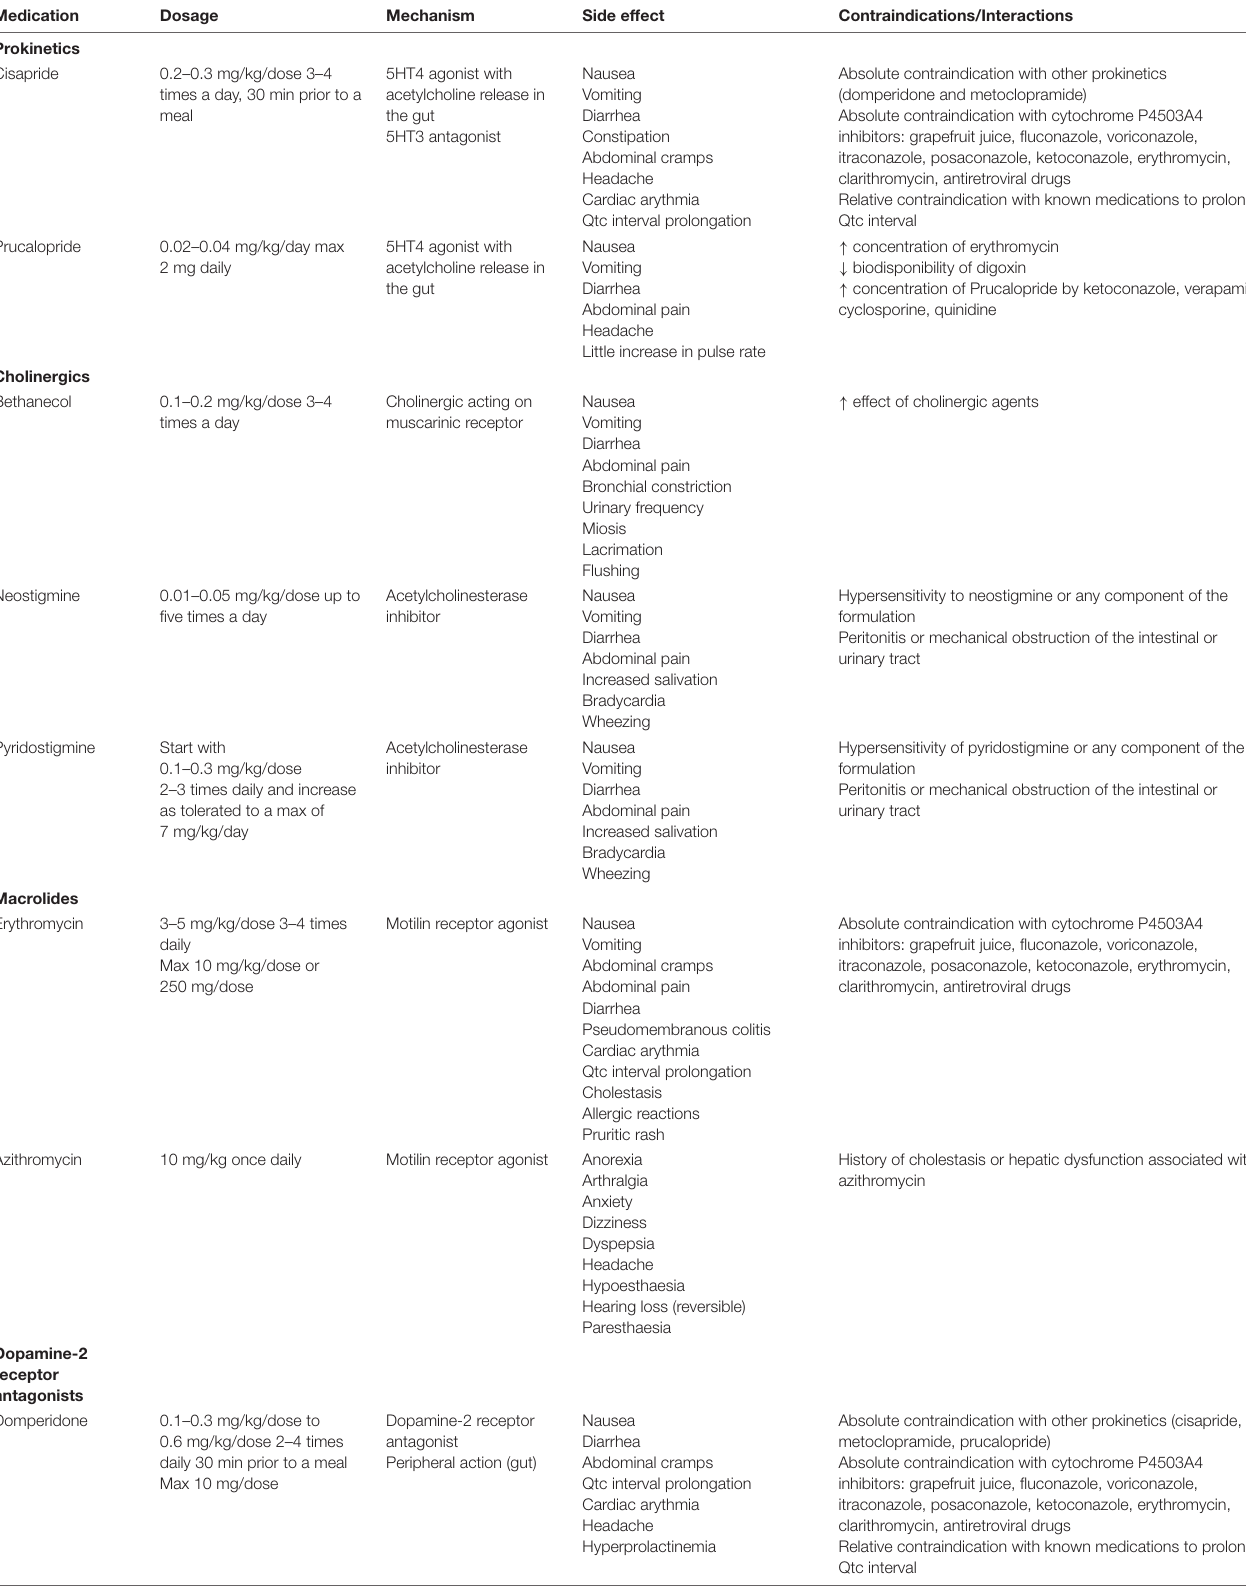
TABLE 3 | Prokinetic drugs used in Pediatric Intestinal Pseudo-Obstruction.